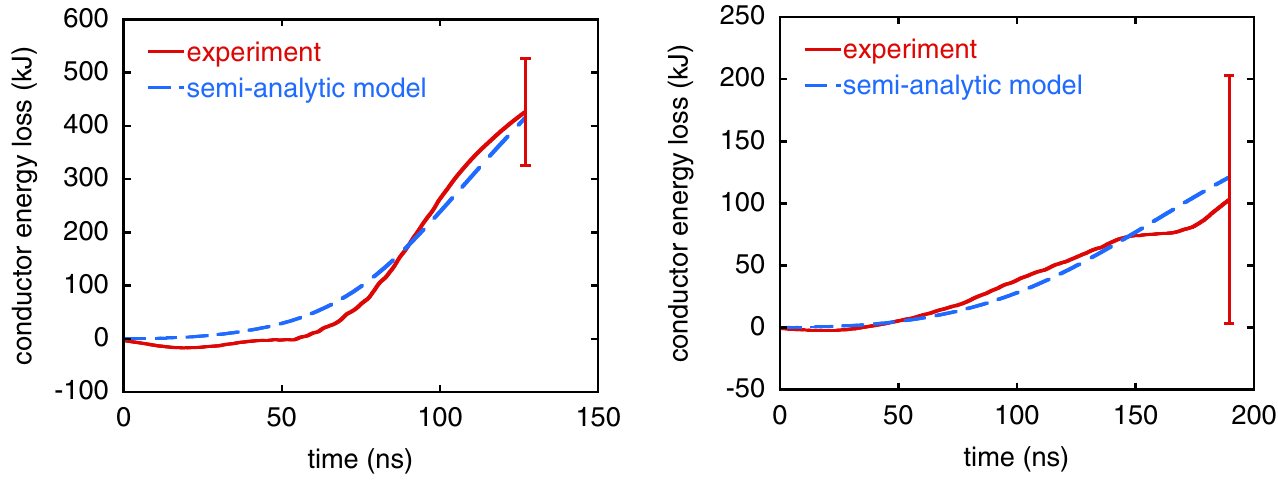
FIG. 7. (Color) Comparison of the measured conductor energy loss on Z-shot 533 with the prediction of the semianalytic model, as given by Eq. (35). The conductor system used as the load on this shot is that illustrated by Fig. 4. The plot includes a representative error bar.